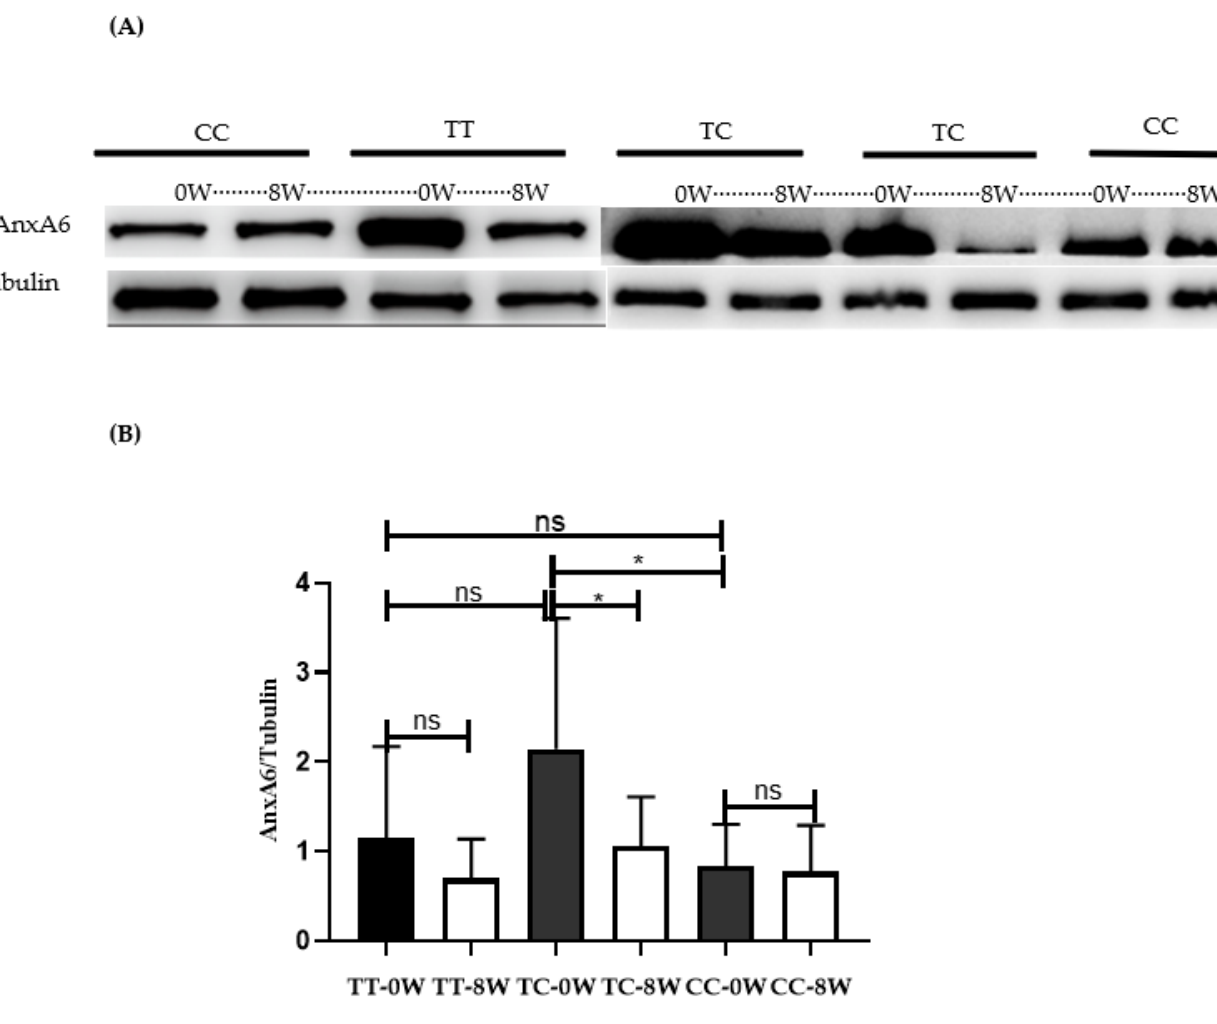
Figure 1. The effect of MTX and the rs11960458 genotype on the expression of AnxA6 in PBMCs. ( A ) Western blots showing the expression of AnxA6 at baseline and at week 8, according to the rs11960458 genotype after MTX treatment in 22 psoriatic patients (4 patients with TT genotype, 9 patients with TC genotype, and 9 patients with CC genotype); ( B ) The expression of AnxA6 in PBMCs was significantly higher in TC genotype carriers of rs11960458 than in CC genotype carriers, and it was significantly decreased in TC genotype carriers after MTX treatment. * p < 0.05, one-way ANOVA (Tukey’s multiple comparisons test) and paired t -test were